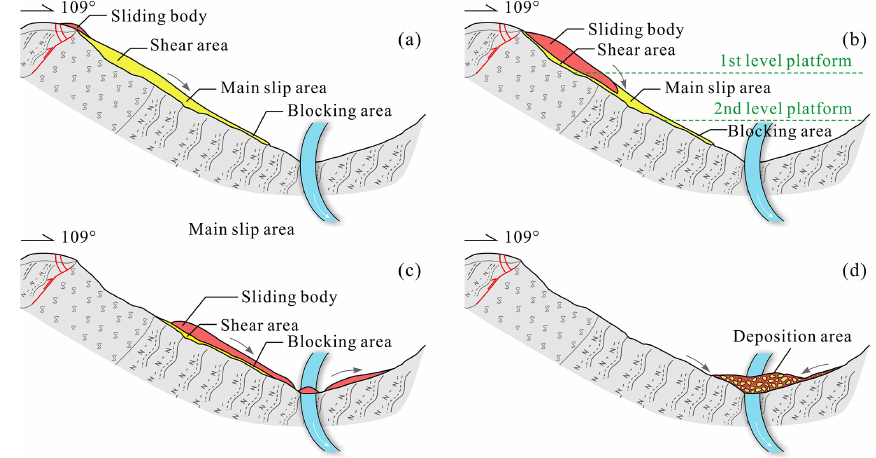
Figure 14. Schematic diagram of the Baige landslide model: (a) stage 1 – initiation; (b) stage 2 – main slip; (c) stage 3 – crawling up against the slope (blocking); and (d) stage 4 – falling back and accumulation